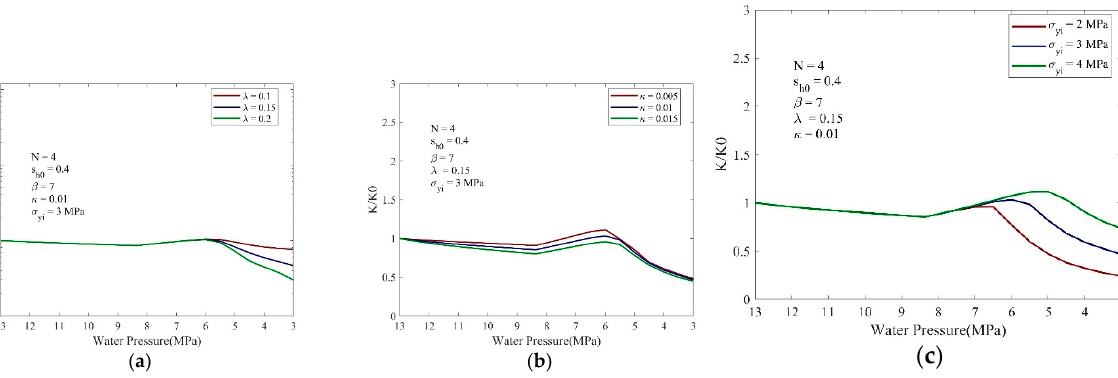
Figure 14. The impact of different parameters on permeability ratio K/K0 included in the scenario of heat insulation ( a ) parameter λ , ( b ) parameter κ and ( c ) precondition pressure σ ’ y .